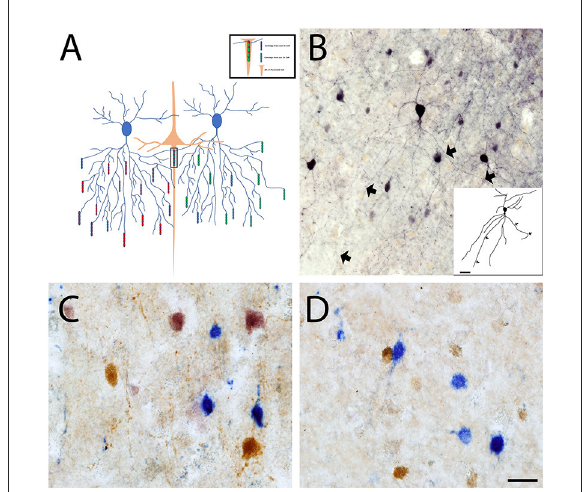
FIGURE1 Chandelier cell connectivity and immunostaining. (A) Chandelier cells (blue) have a unique and structurally complex morphology characterized by vertically oriented axon terminal cartridges (red and green), that are perpendicular to the pial surface. Ch cells synapse onto the AIS of pyramidal neurons (orange) and can innervate up to 250 pyramidal cells at once, allowing for fine inhibitory control. (B) Ch cell in primary somatosensory cortex stained with an anti-PV antibody that labels the soma and proximal processes (BA3). Triple enzymatic stain of CR (Blue), CB (Brown) and PV (Pink) labeled interneurons reveals loss of PV + interneurons in BA3 of both control (C) and ASD cortex (D) . Scale Bars = 20 µ